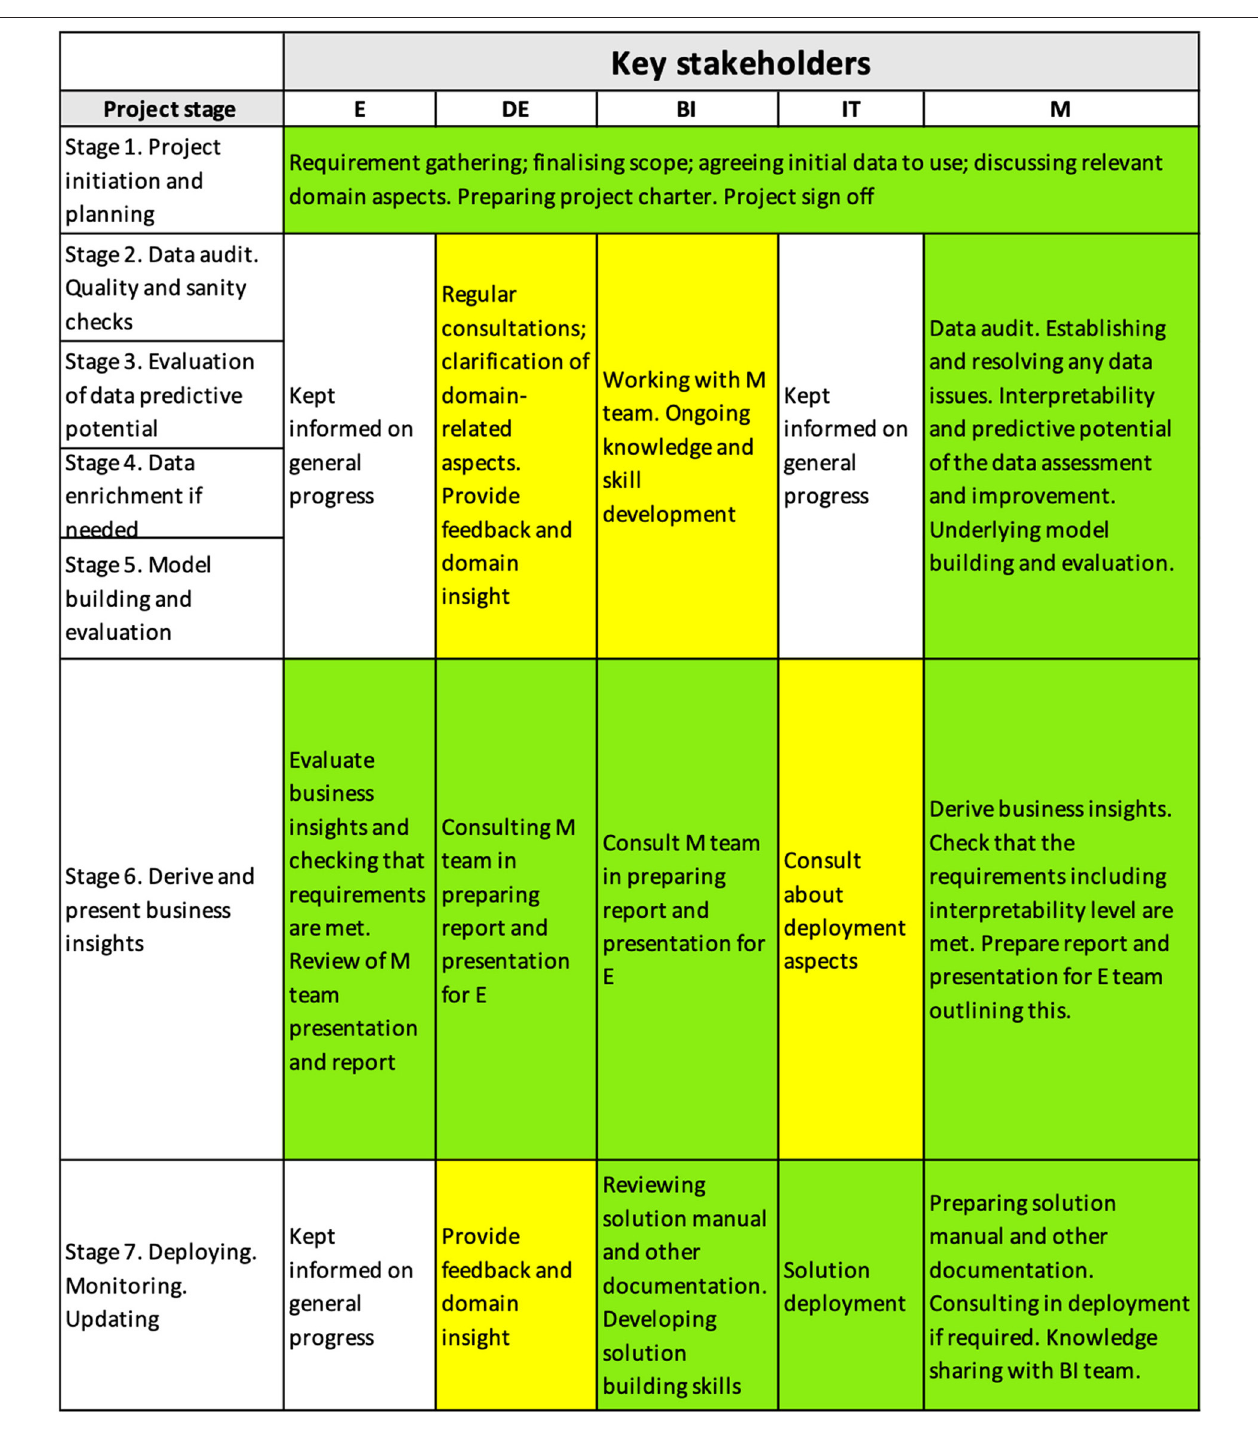
FIGURE 2 | High-level interpretability matrix for the project.